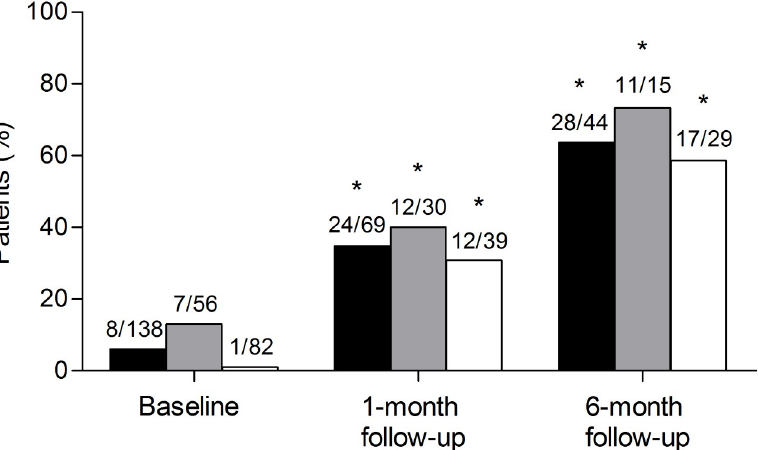
Fig 3. Patients who correctly administered their eye-drops at baseline and follow-ups. Number of patients who correctly administered eye-drops prior to counseling at baseline, 1-month follow-up, and 6-month follow-up in relation to the total number of patients (black), all patients in the intervention group (grey), or in the control group (white) who were assessed for eye-drop administration errors. � significant compared to baseline (p � 0.001).